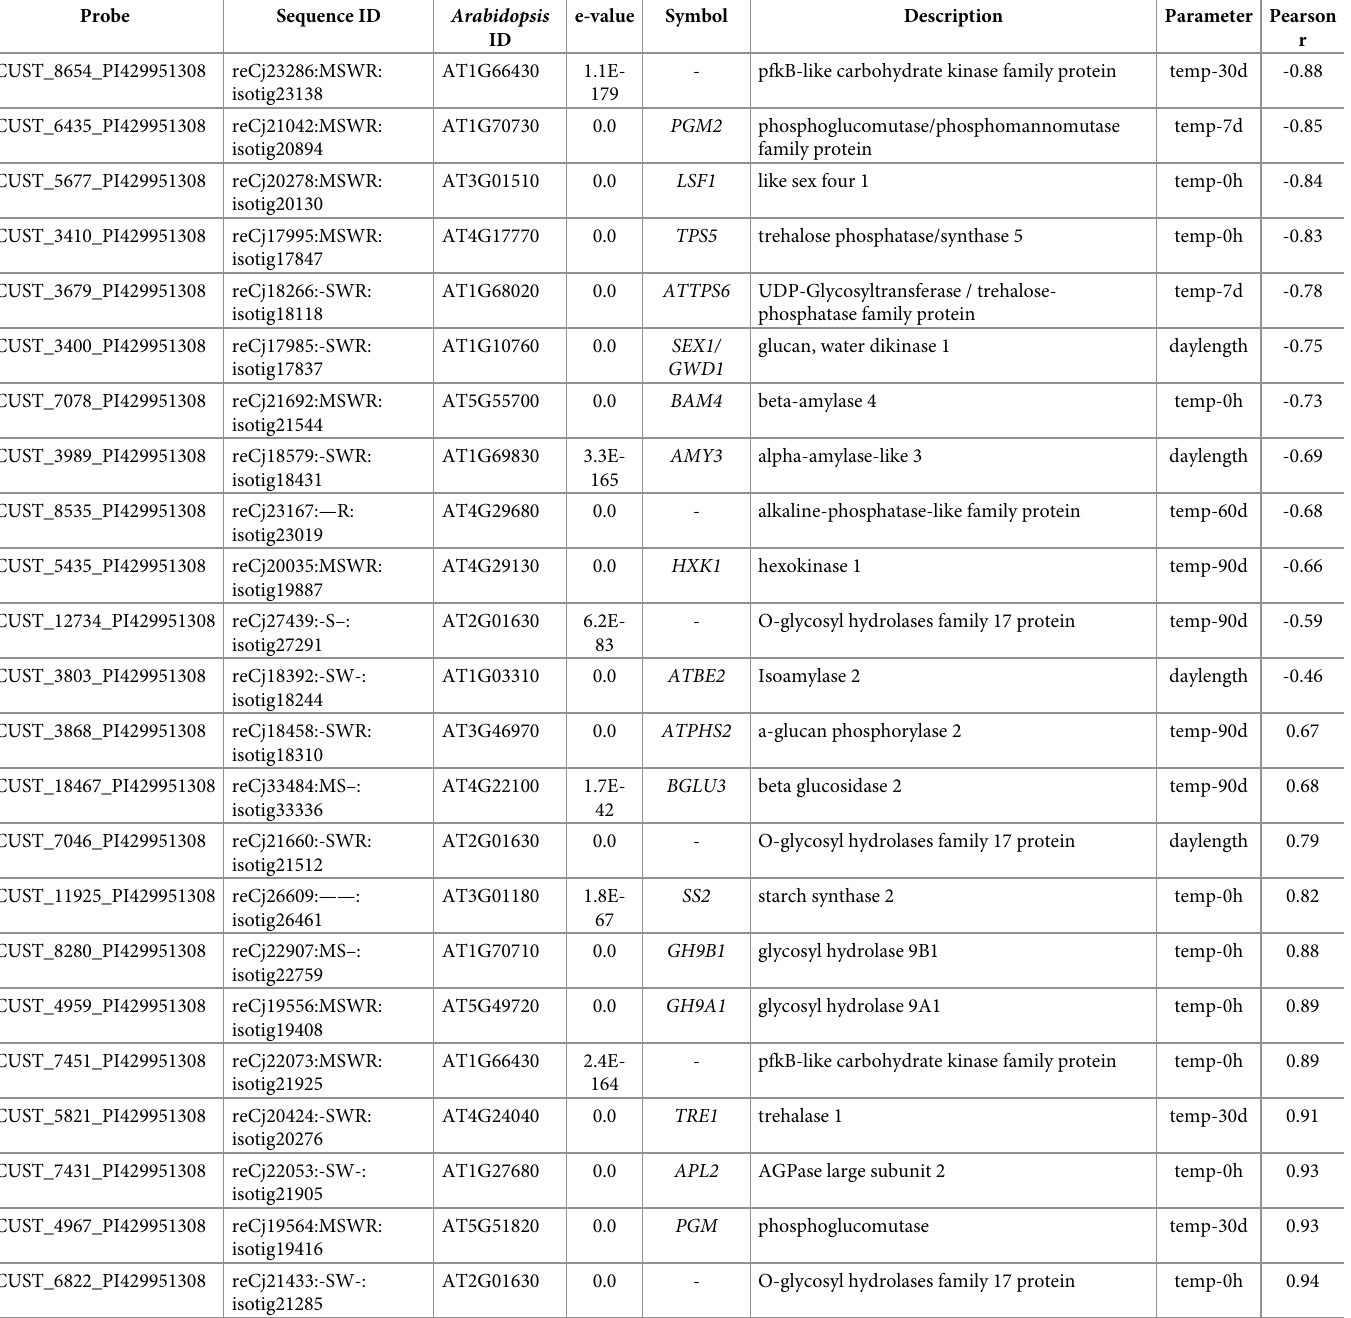
Table 7. Starch- and sugar-related genes exhibiting differential expression patterns among the three sites.